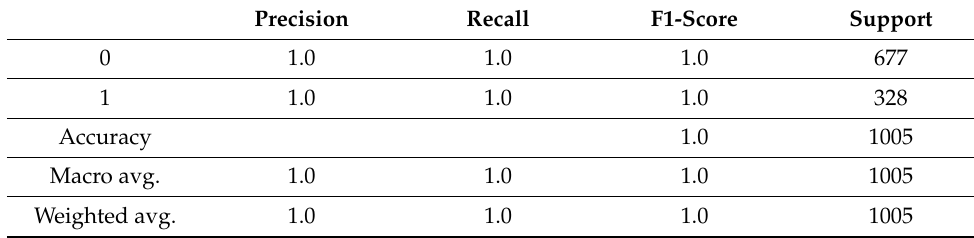
Table 15. SVM classification report.